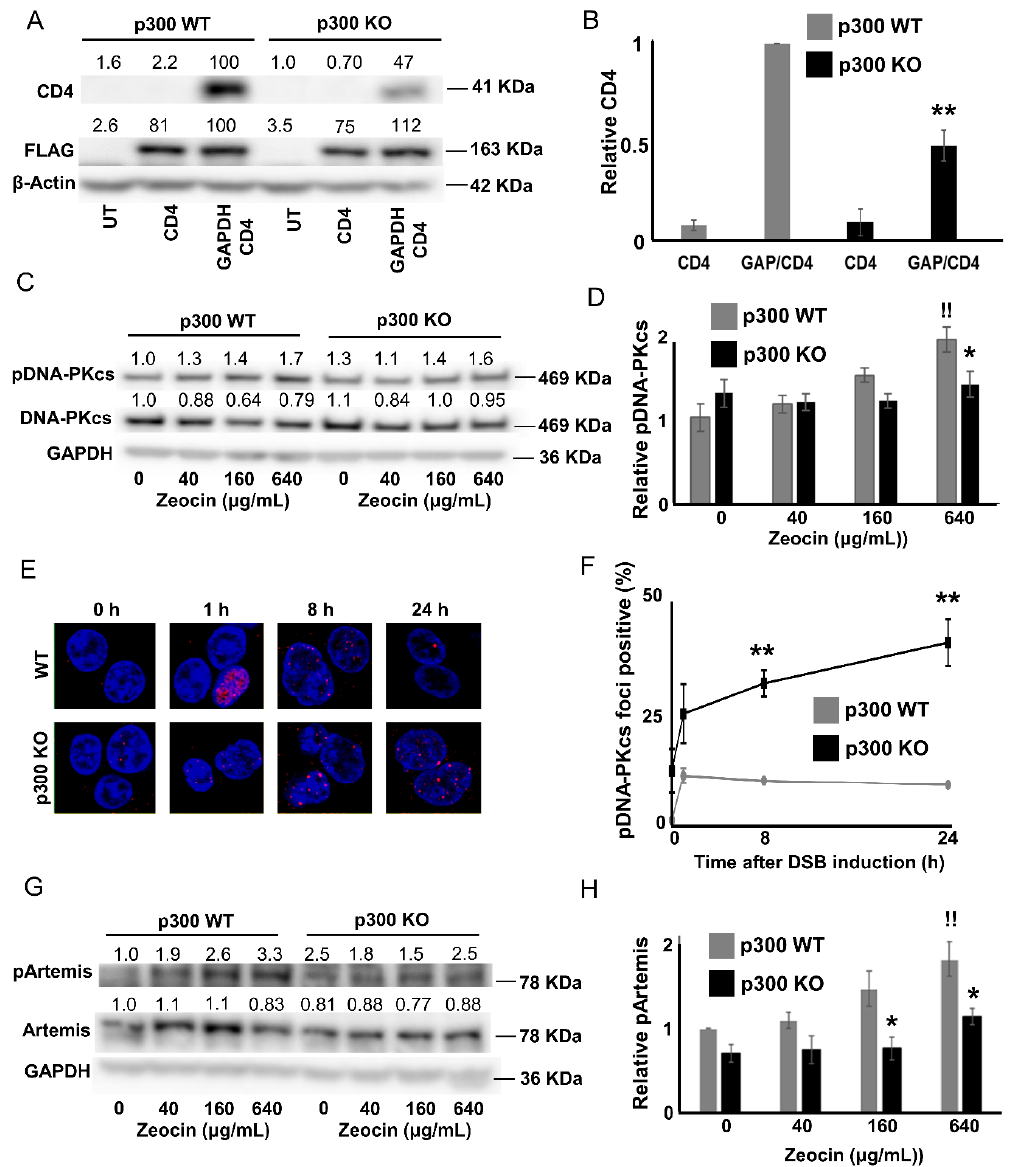
Figure 6. HCT116 P300 knockout decreases NHEJ efficiency. ( A ) Representative immunoblots showing CD4 expression in HCT116 p300 WT and HCT116 p300 KO after transfection with control (UT), FLAG-tagged SgRNA-CAS9 targeting CD4 (CD4), and FLAG-tagged SgRNA-CAS9 targeting GAPDH and FLAG-tagged SgRNA-CAS9 targeting CD4 (GAP/CD4). ( B ) Densitometry of immunoblots ( n = 3) from panel A. CD4 was normalized to β -actin as a loading control. Transfection efficiency was accounted for using FLAG abundance. ( C ) Representative images of immunoblot of pDNA-PKcs and total DNA-PKcs in HCT116 p300 WT and HCT116 p300 KO. ( D ) Densitometry of pDNA-PKcs normalized to total DNA-PKcs and GAPDH as a loading control. Data is shown relative to HCT116 WT control. ( E ) Representative images of pDNA-PKcs foci following Zeocin exposure. ( F ) Percentages of pDNA-PKcs foci positive (> 2) HCT116 cells following Zeocin exposure. All microscopy images are 400X magnification. ( G ) Representative immunoblot of pArtemis and total Artemis of HCT116 cells. ( H ). Densitometry of immunoblots ( n = 4) of pArtemis normalized to total Artemis, and to GAPDH as a loading control. All values are represented as mean ± standard error, from at least three independent experiments. Statistical differences between groups were measured